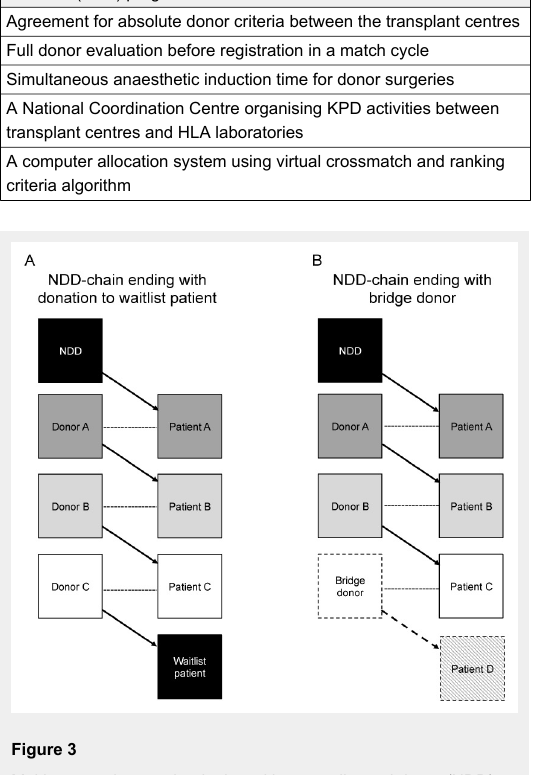
Table 1: Key ingredients for a successful national kidney paired donation (KPD) programme.